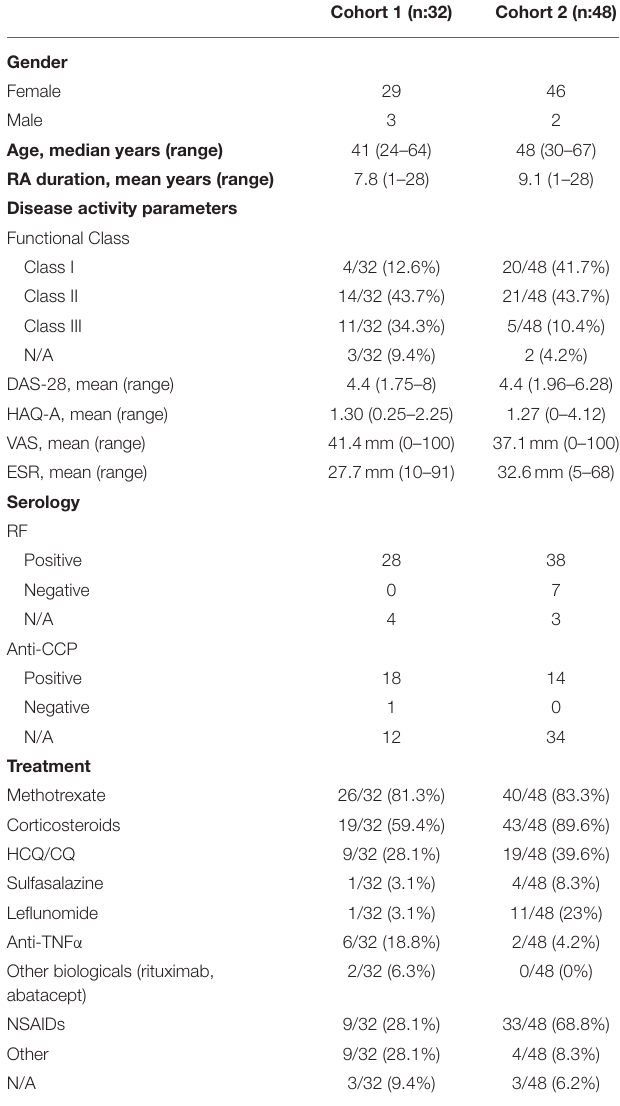
TABLE 1 | Demographic, clinical, and laboratory characteristics of patients with